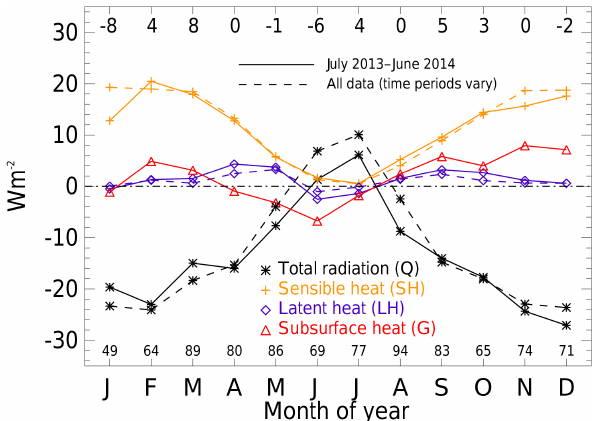
Figure 3. Monthly–hourly mean values from July 2013 to June 2014 of (a) total radiative flux, (b) sensible heat flux, (c) conduc- tive heat flux, and (d) latent heat flux. Black contour lines indicate the solar elevation angle. Units on the color bars are all in Wm − 2